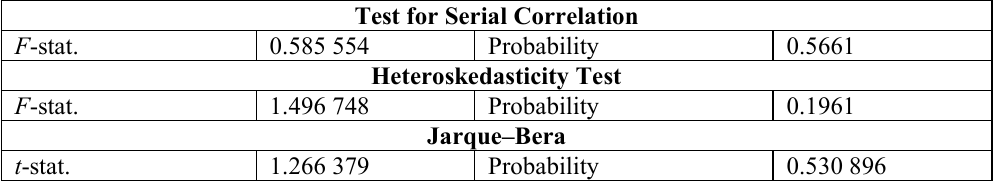
Table 6. Diagnostic Tests (The authors’ computation, 2021) Test for Serial